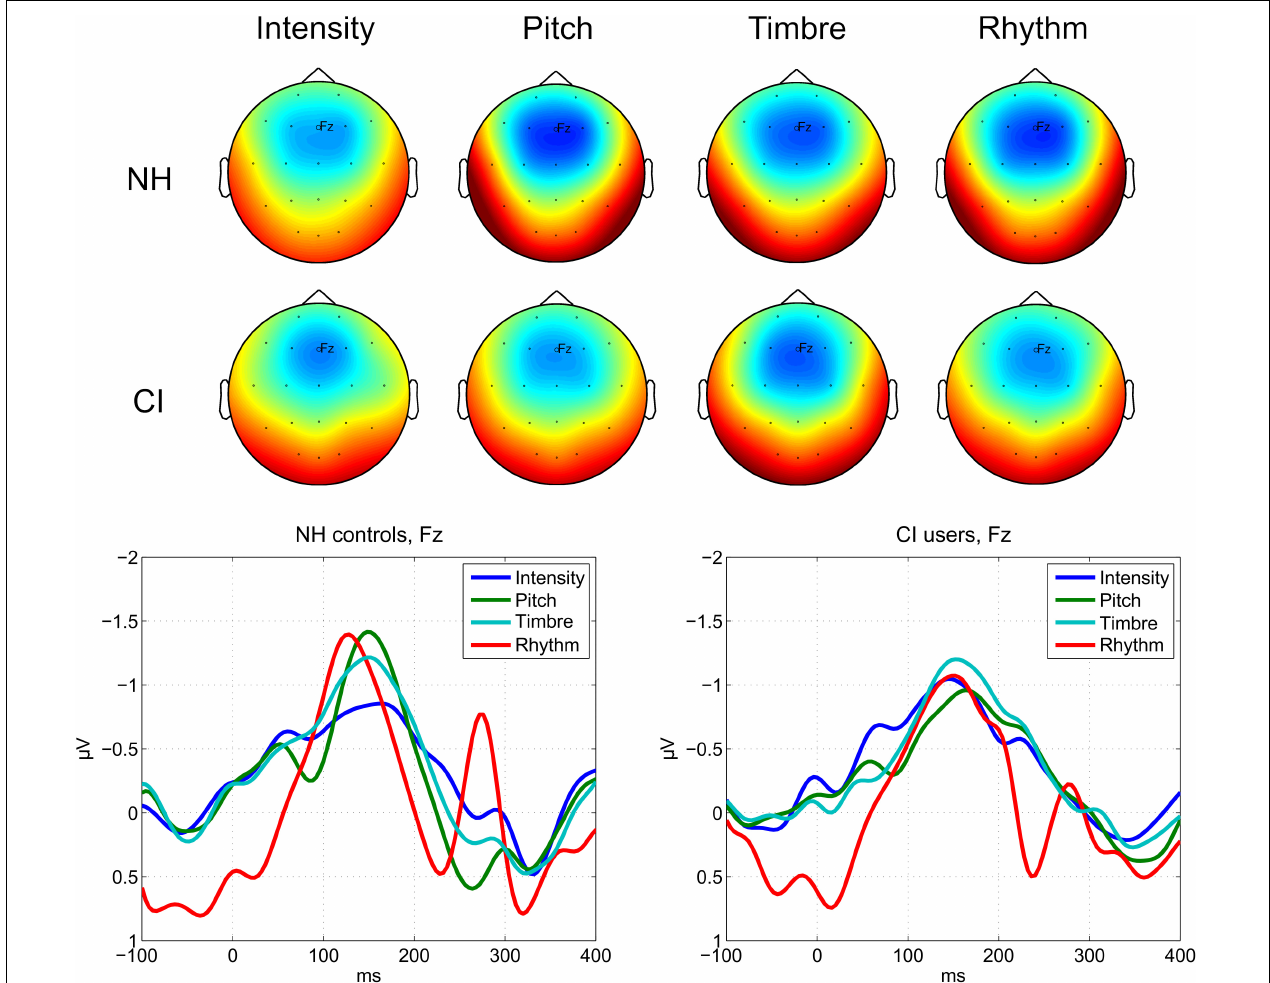
FIGURE 3 | MMN responses to deviants in each auditory feature. (Top) Average MMN scalp topographies measured in a 30 ms time window centered on the peaks for each feature. The colors are scaled from –2 µ V (blue) to +2 µ V (red). NH, normal hearing controls; CI, adult cochlear implant users. (Bottom) Average MMN waveforms for each feature and group measured at the Fz